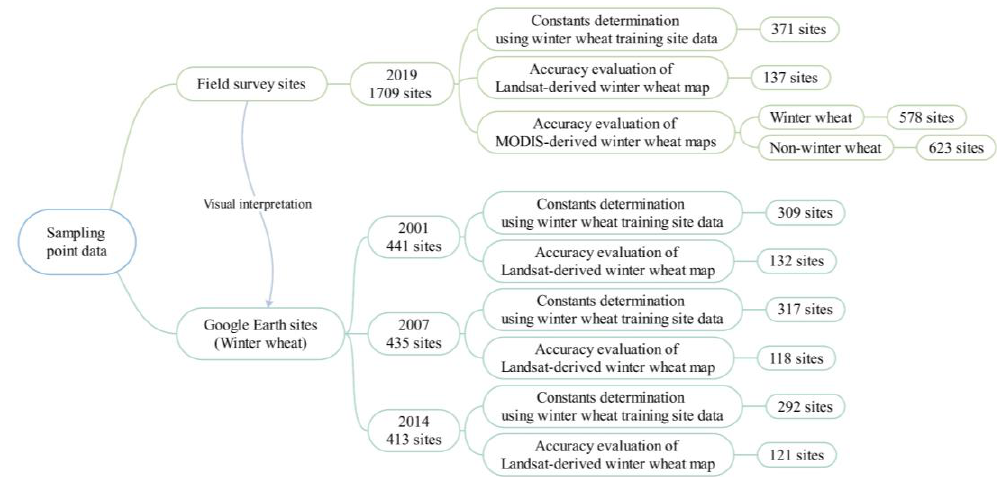
Figure 2. Basic details of the sampling point data. The figure includes the source of the sampling point data and the application of the data in 2001, 2007, 2014 and 2019.